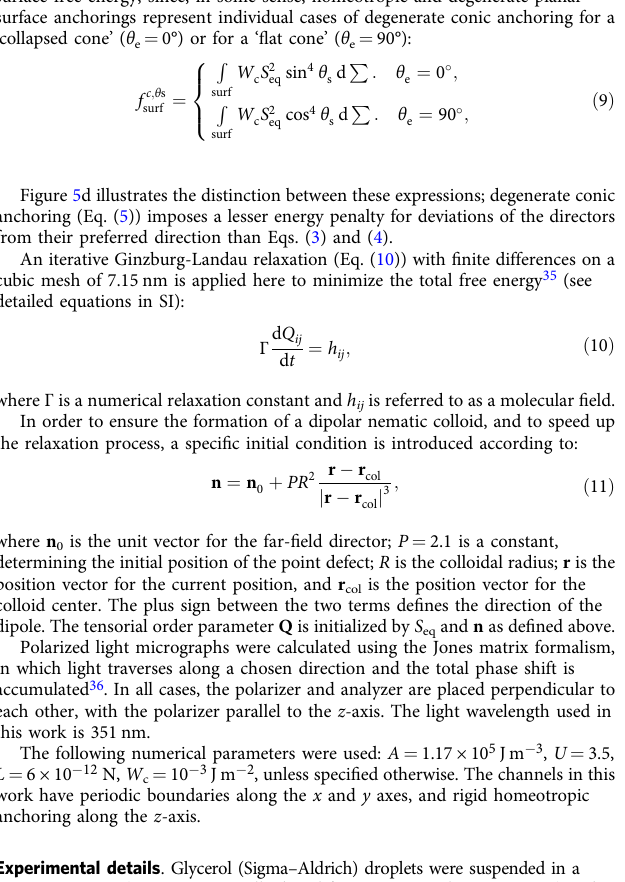
f c θ s for a range of preferred tilt angles. surf as a function of surface director tilt angle Again, these results demonstrate that, guided by the Q- tensor-based Eq. (5) proposed here, the surface directors favor orientation along a conic plane with an angle θ e to the surface normal. When compared to Eqs. (3) and (4), Eq. (5) provides a universal expression for surface free energy, since, in some sense, homeotropic and degenerate planar surface anchorings represent individual cases of degenerate conic anchoring for a ‘ collapsed cone ’ ( θ = 0°) or for a ‘ fl at cone ’ ( θ = 90°): e e